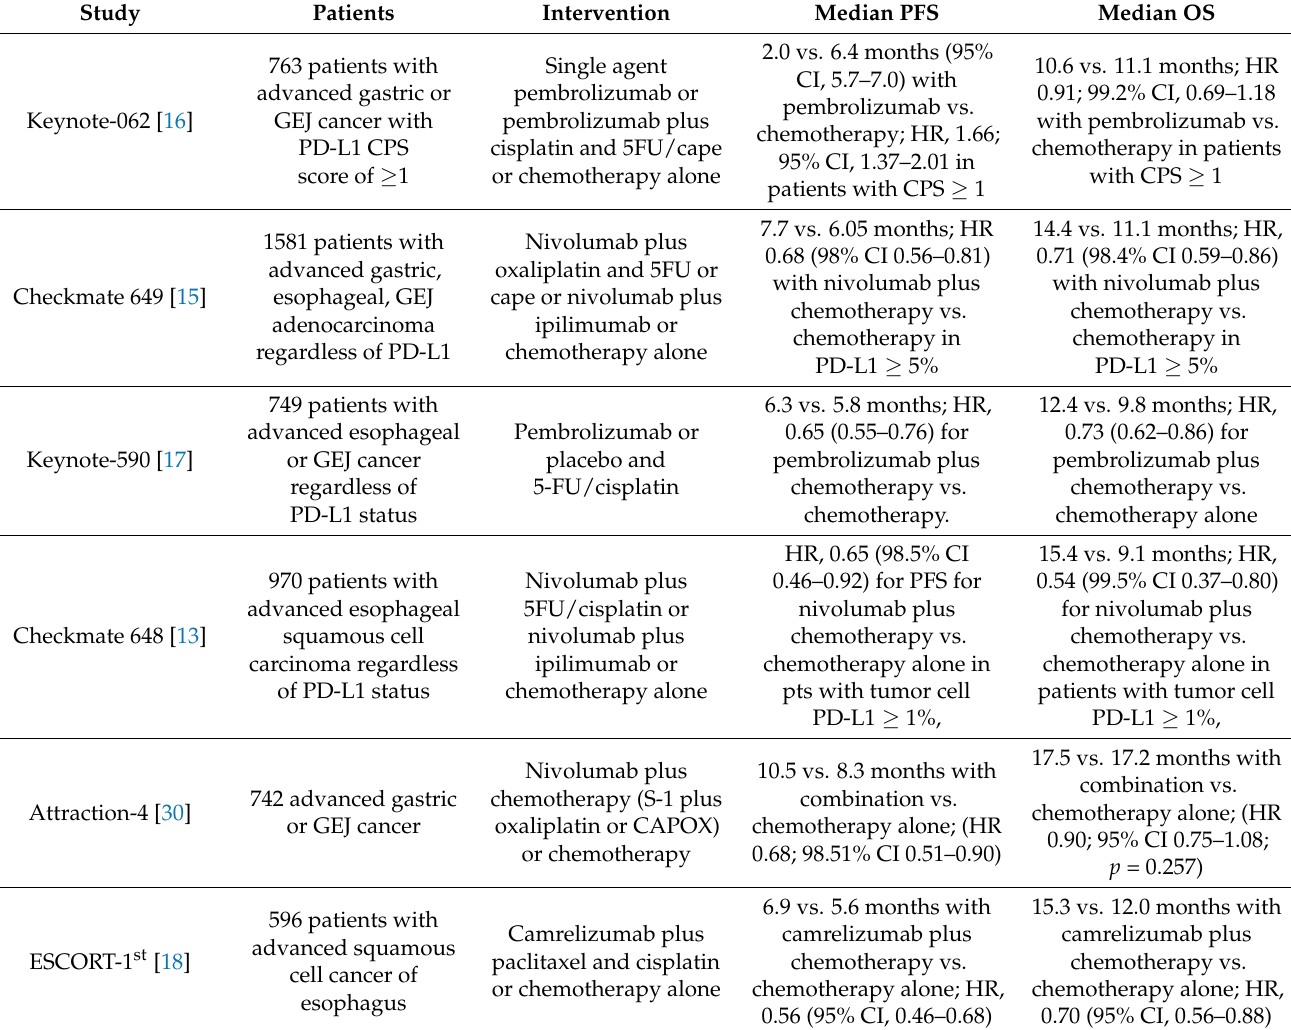
Table 1. Summary of pivotal phase III trials evaluating the efficacy of checkpoint inhibitors in patients with previously untreated metastatic gastric, esophageal and GEJ